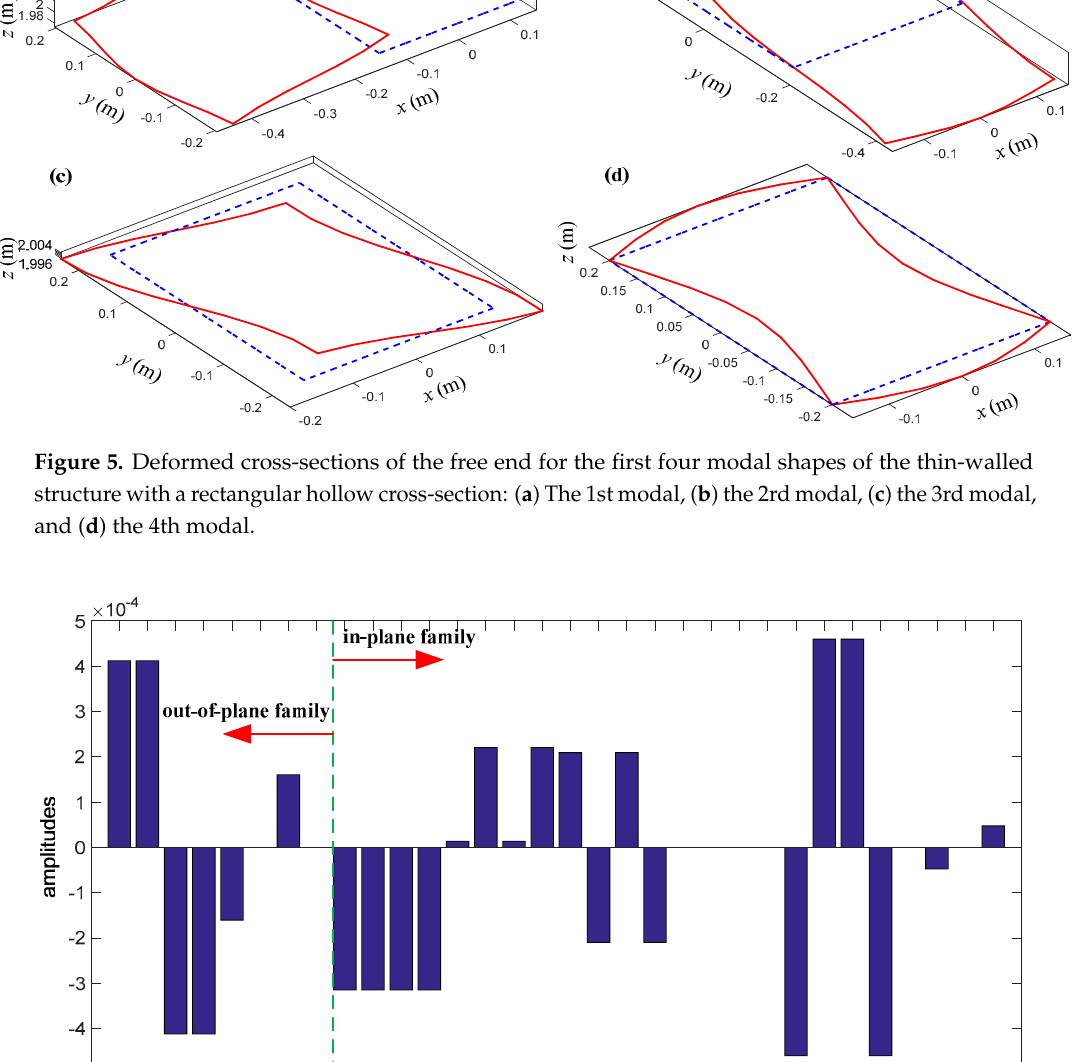
Figure 6. Amplitudes of basis deformation modes participating in the first modal of the free end cross-section of a cantilevered thin-walled structure.